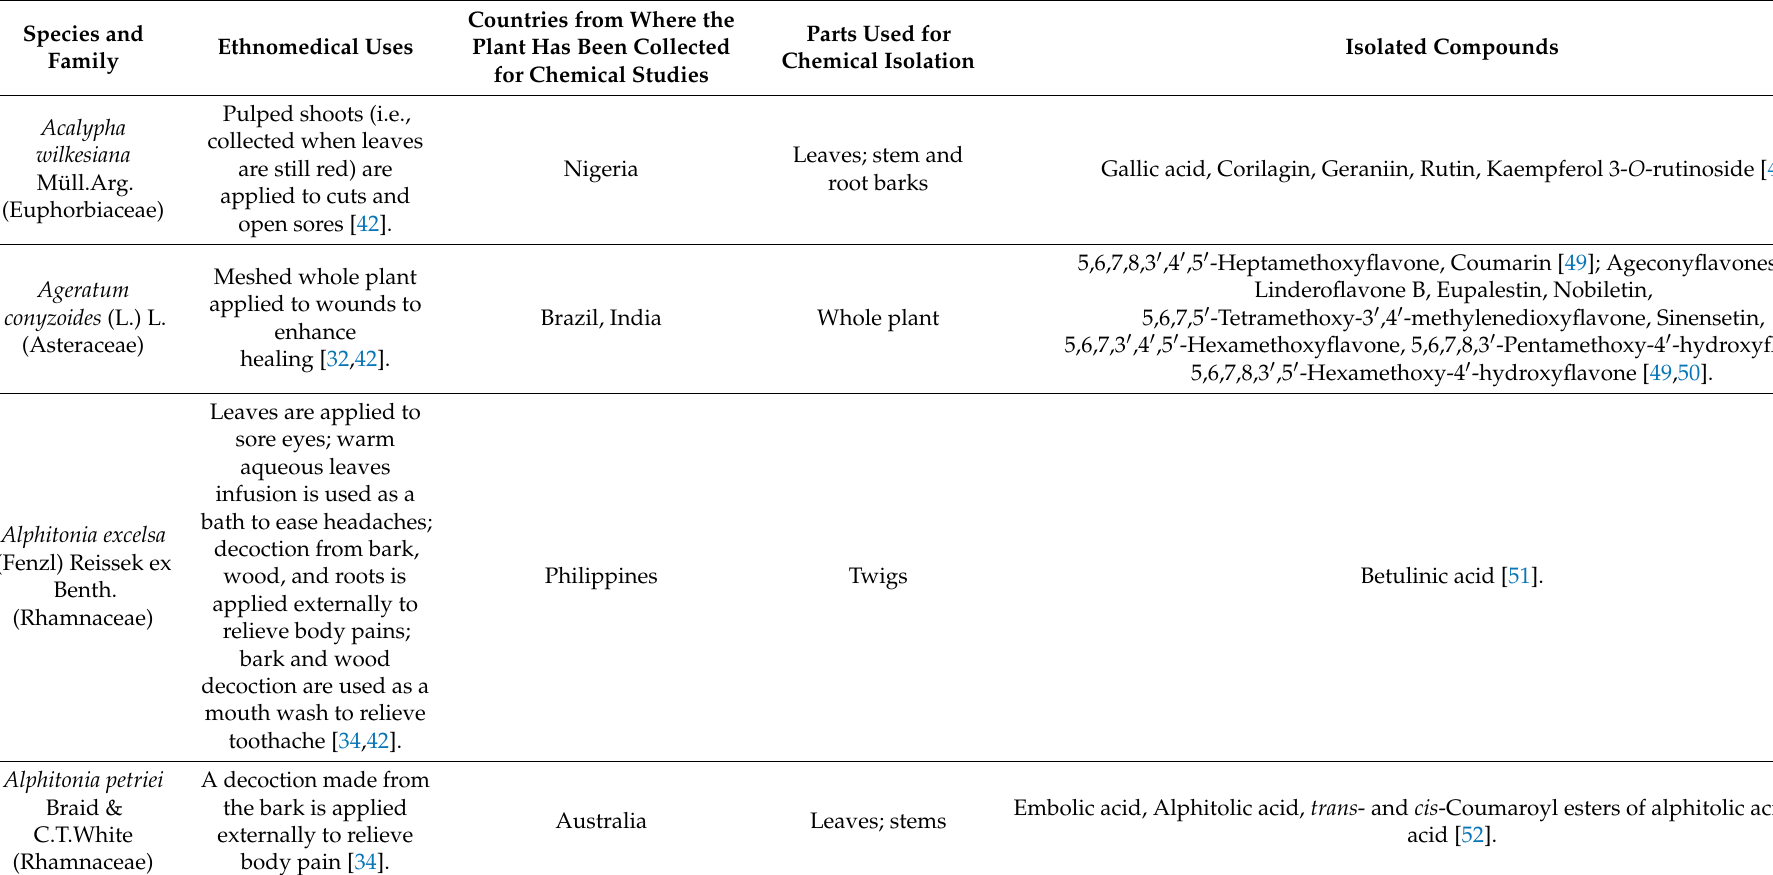
Table 1. Ethnomedical uses and the compounds isolated from Aboriginal tropical medicinal plants of